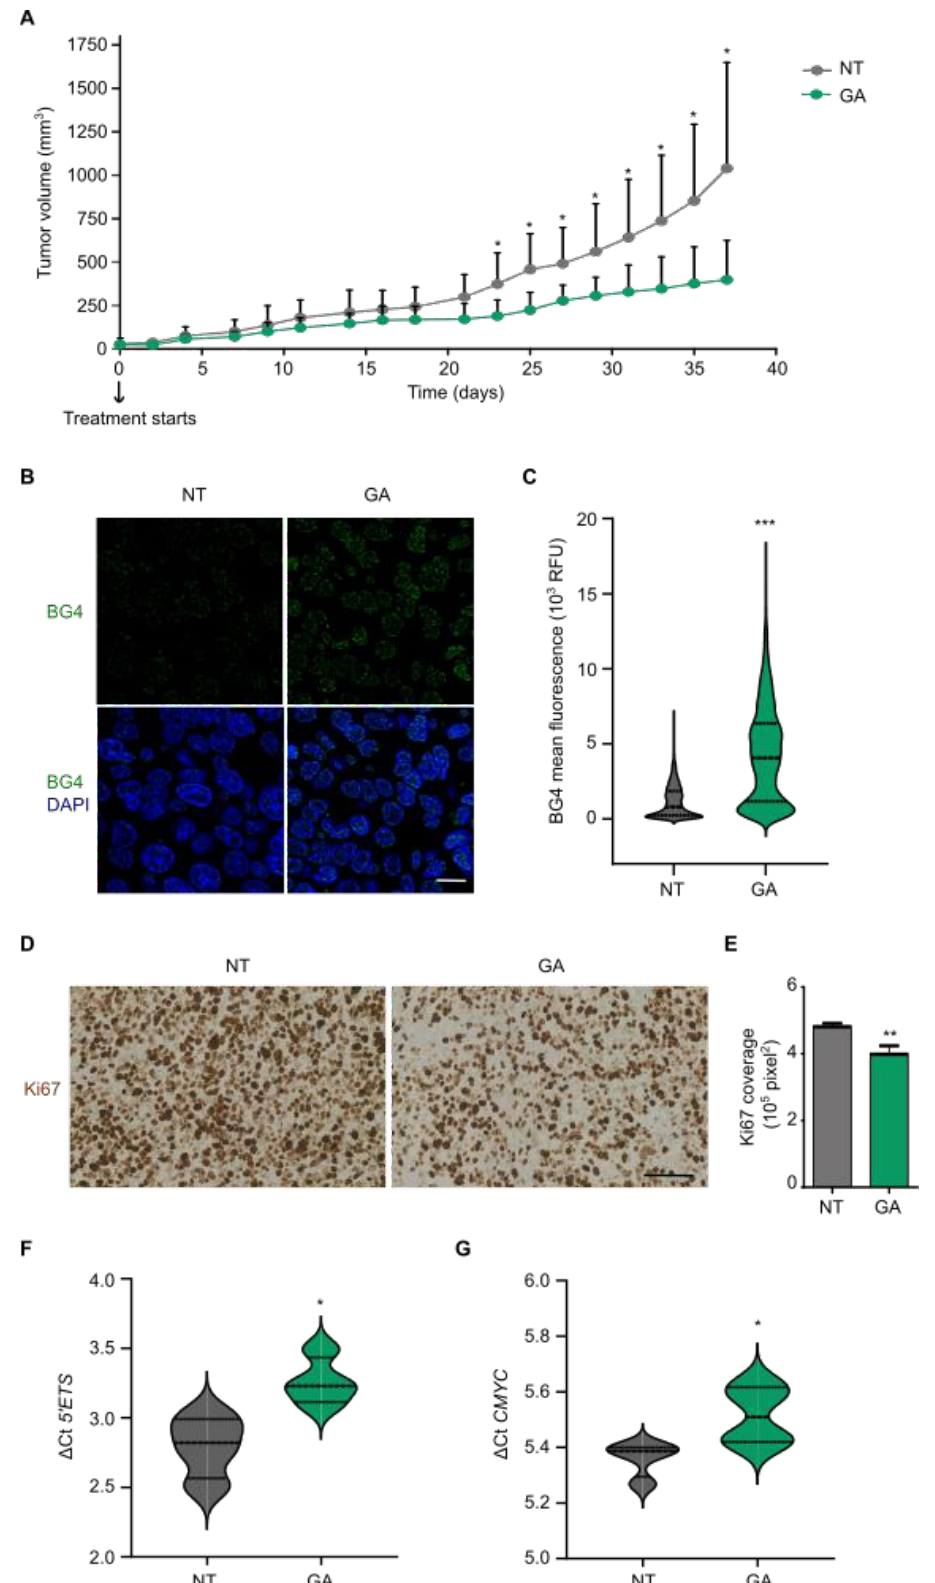
Figure 4. Gallic acid blocks tumor progression and binds to G4s in vivo. ( A ) Tumor volume of SW480 xenograft mice treated with DMSO vehicle control (N = 5) or 200 mg/kg GA (N = 7) every other day for 38 days. Each point represents the mean tumor volume of the group ± standard deviation (only the positive bars are shown). ( B ) Representative images of BG4 immunofluorescence in tumor sections from control and GA-treated xenografts. Merged images with DAPI for DNA